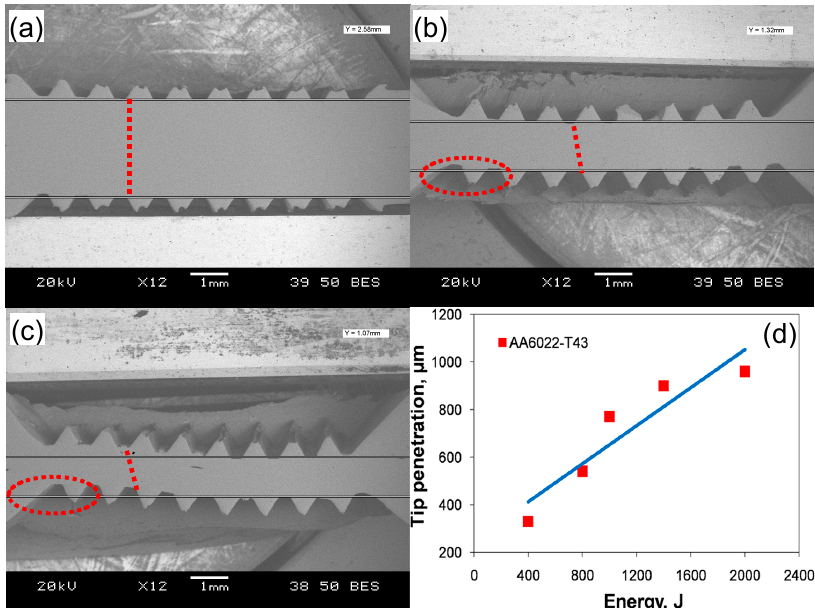
Figure 1. Typical cross-sections of ultrasonic spot welded joints made with a welding energy of ( a ) 800 J; ( b ) 1400 J; ( c ) 2000 J; along with ( d ) Sonotrode welding tip tooth penetration into the aluminum workpiece as a function of the welding energy from 400 J to 2000 J.